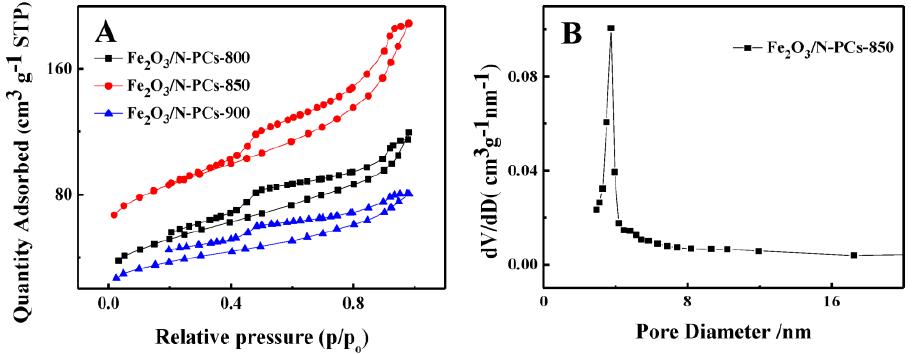
Figure 2. Nitrogen desorption-adsorption isotherm of Fe 2 O 3 /N-PCs-800, Fe 2 O 3 /N-PCs-850, Fe 2 O 3 /N-PCs-900.